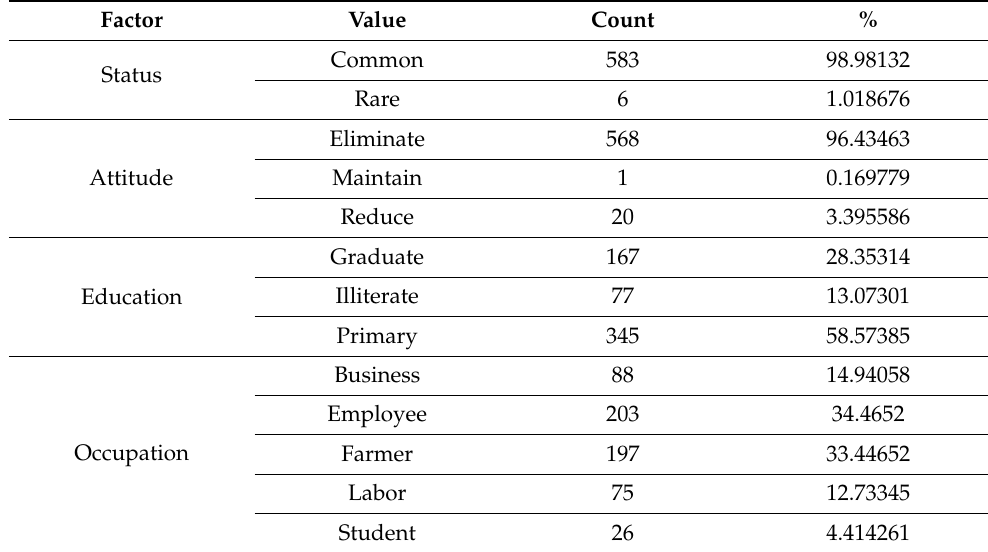
Table 8. Categorical factors used in the GLM model associated with the attitudes towards wild boars ( n = 589). The values shown include the number of respondents for each level (counts) and the percentages (%) for each factor.